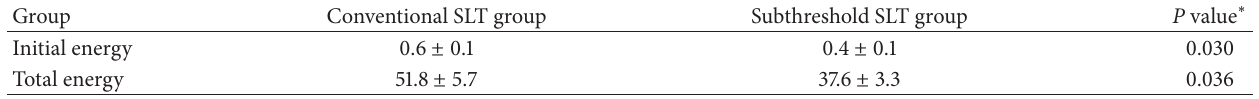
Table 2: Energy dosage (mJ) used in conventional SLT group and subthreshold SLT group.